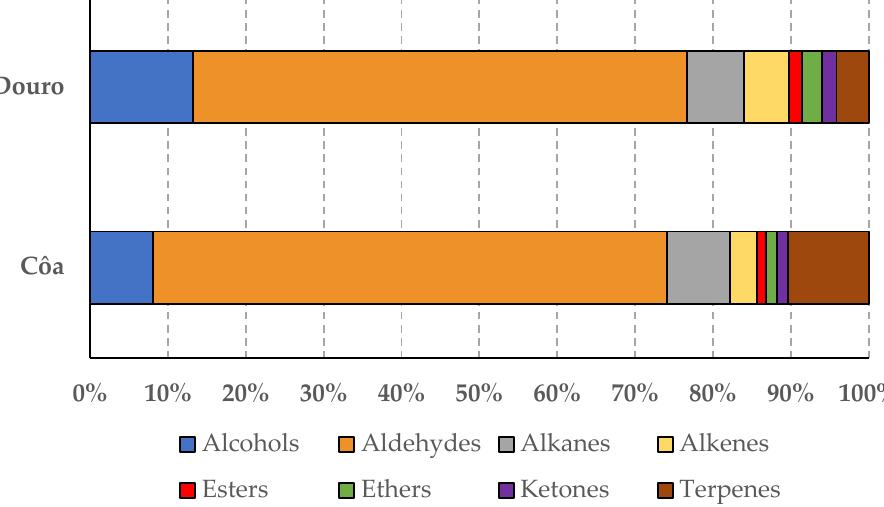
Figure 2. Relative abundance (%) of the chemical classes of the identified VOCs for the olive oils from Côa or Douro geographical origins.